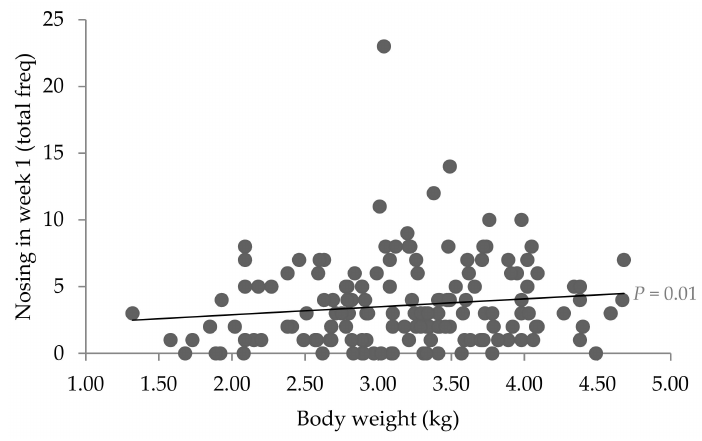
Figure 3. Relationship between piglet body weight and the frequency of piglet-to-sow nosing behaviour in the first week of life ( n = 160 piglets).